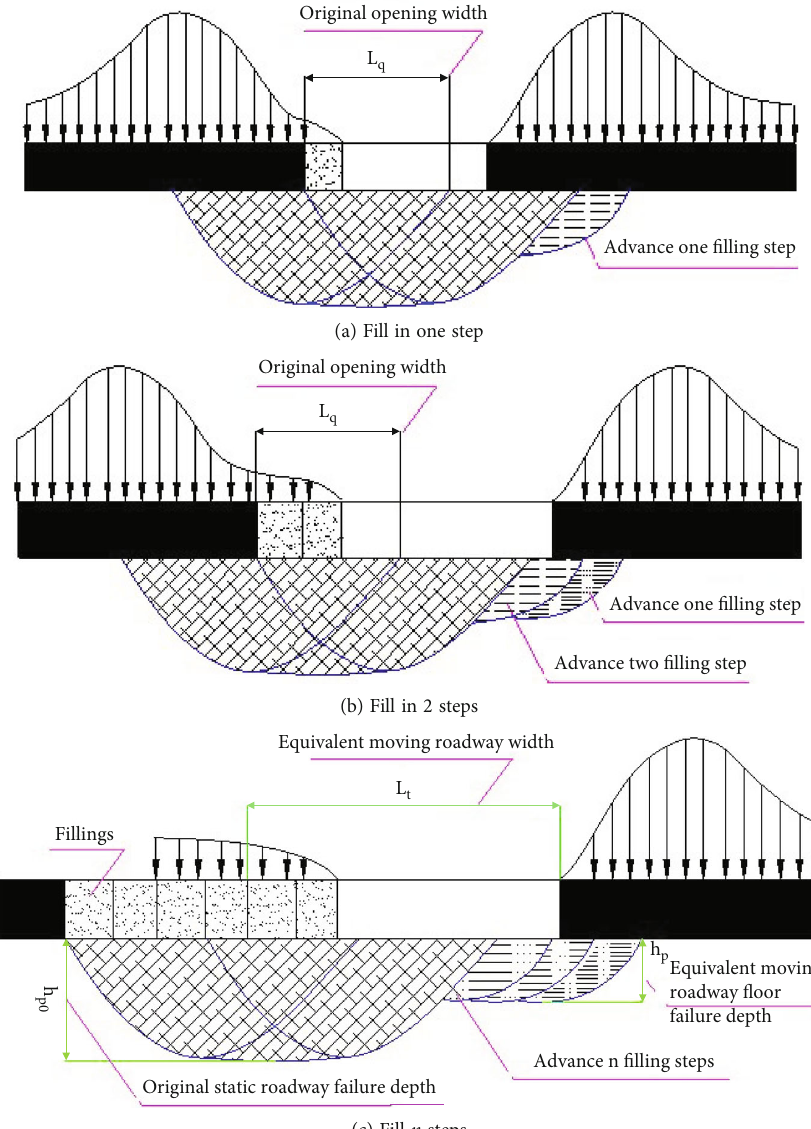
Figure 4: The relationship between equivalent roadway width and fl oor failure